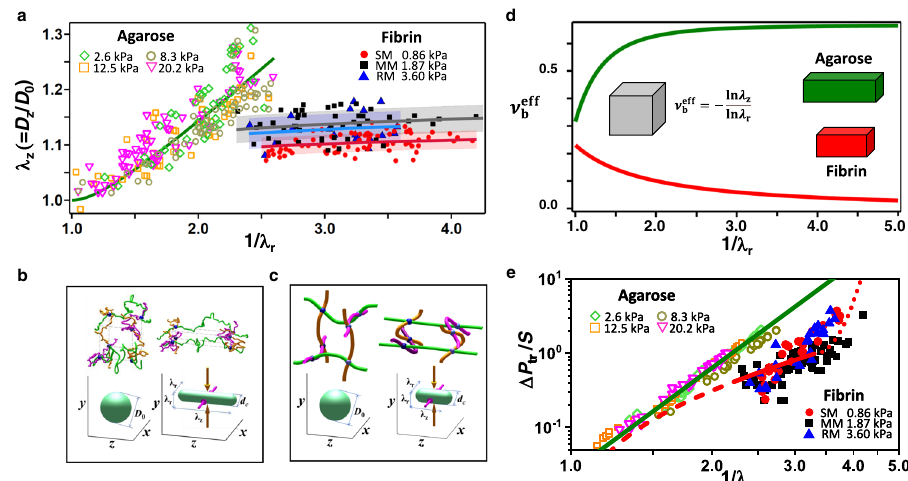
Fig. 2 Biaxial compression of fi brin and agarose gels. a Variation in experimentally measured elongation λ z of agarose microgels with various elastic moduli (2.6 kPa, green hollow diamonds; 8.3 kPa, brown hollow circles; 12.5kPa, orange hollow squares; and 20.2 kPa, magenta hollow inverted triangles) and SM (red solid circles), MM (black solid squares), and RM (blue solid triangles). The solid lines show theoretically predicted λ z of agarose (green line) and fi brin microgels (the colors of lines and symbols coincide). b , c Top: schematic of network strands of agarose ( b ) and fi brin ( c ) prior to (left) and after (right) biaxial compression. Bottom: the shapes of the corresponding networks before and after deformation. The compression directions x and y are shown by the magenta and brown arrows, respectively. In the top cartoons, the network strands oriented along these x and y directions are shown as the corresponding magenta and brown color lines, while the strands oriented in the unconstrained z-direction are depicted by green lines. In fi brin gel ( c ), magenta and brown strands oriented in the x and y directions are bent more than in the undeformed state, whereas the green strands oriented in the z-direction are bent and stretched. Stress between compression and stretching directions is transmitted through the fi laments with intermediate orientations. In agarose gels, the strands of all orientations determine the osmotic pressure, which makes a signi fi cant contribution to gel deformation. ¼ (cid:1) ln λ = ln λ fi brin (red line) gels. Inset d Predicted variation in biaxial Poisson ’ s ratio, ν eff z r , for equi-biaxial compression of agarose (green line) and b illustrates biaxial deformation of gels. e Variation in the translocation pressure, Δ P tr , normalized by the gel stiffness S , plotted as a function of the compression ratio for agarose and fi brin microgels. The colors of symbols correspond to those in ( a ). The green and red lines depict the theoretical relationships between Δ P tr /S and 1/ λ r for agarose and fi brin gels, respectively. The dotted fragment of the red line shows the rise in Δ P tr at strong compression, due to inter- fi ber Figure 1e, f show transmission electron microscopy (TEM) images of the structure of the undeformed and biaxially con fi ned RM. Upon RM con fi nement in the constriction, the size of microgel pores signi fi cantly reduced and their shape became anisotropic, with smaller dimensions in the direction of compression, in agreement with an earlier report 23 .